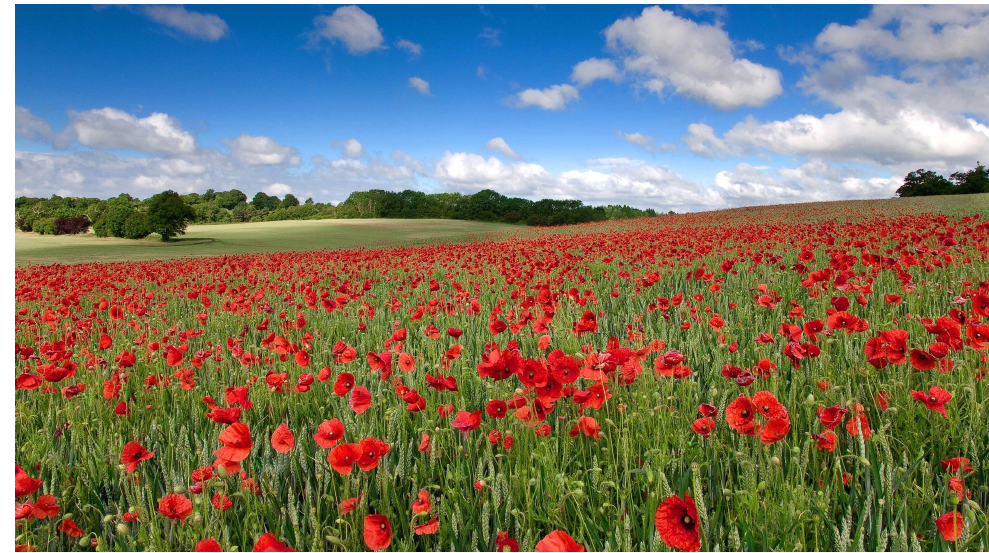
Figure 12. Sample watermarked image obtained by using method 3 and sparse exponential matrix for the message length equal to 50,000